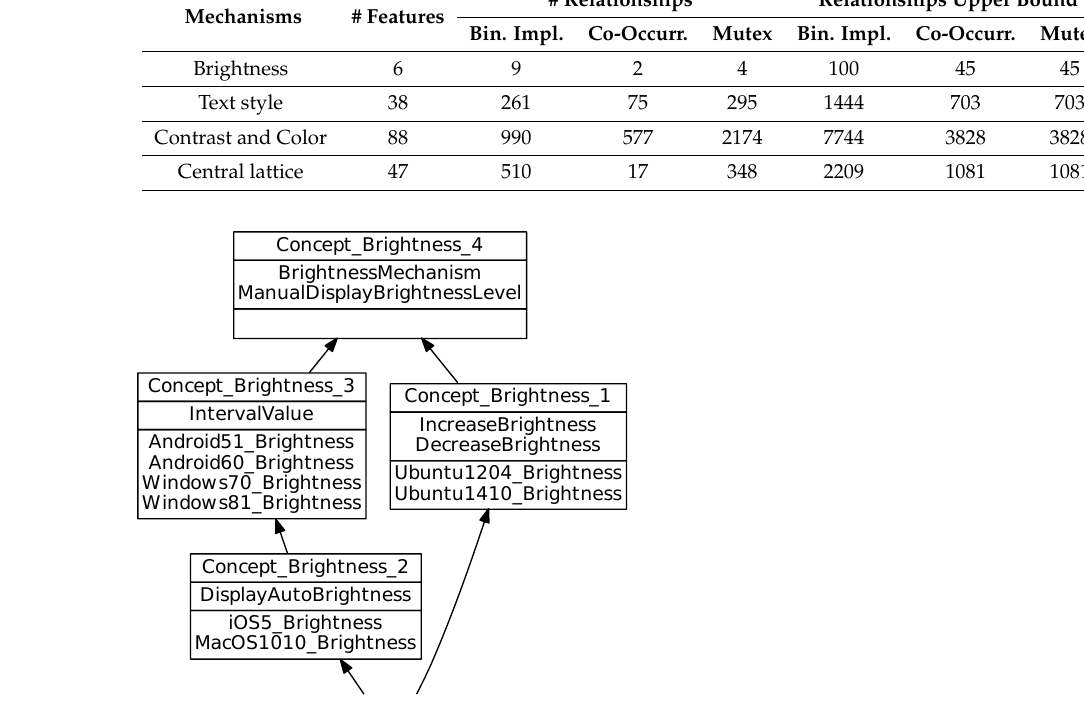
Figure 10. Excerpt of the Brightness concept